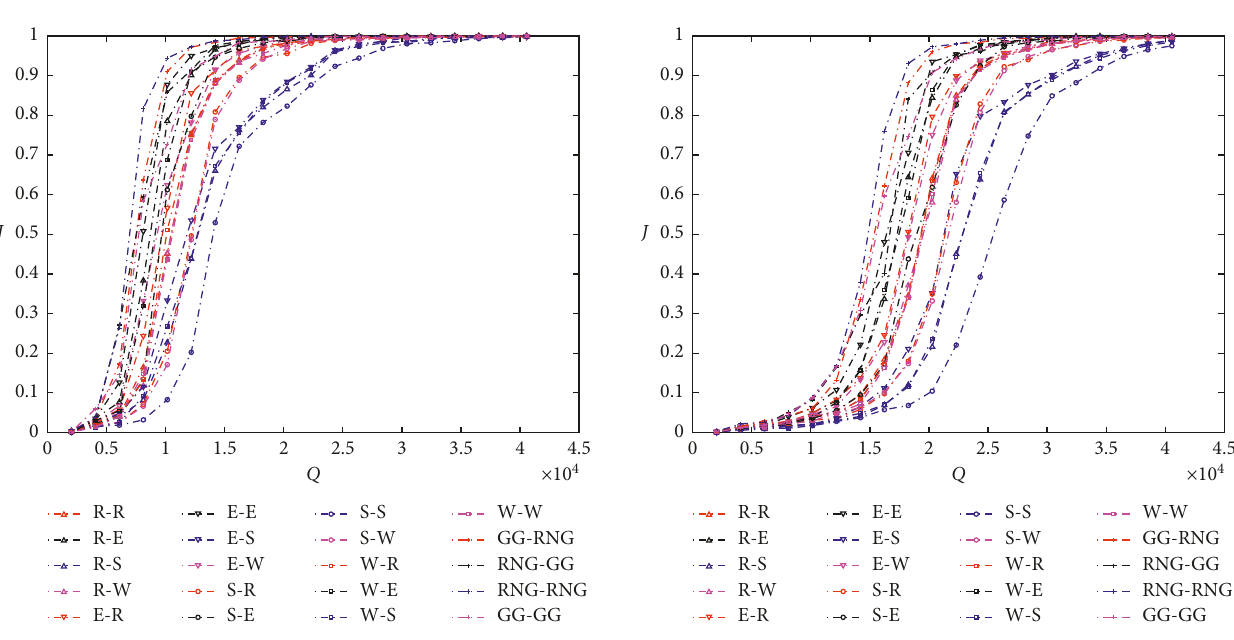
Figure 7: Randomly coupled multilayer network performance as the total traffic flow increases.